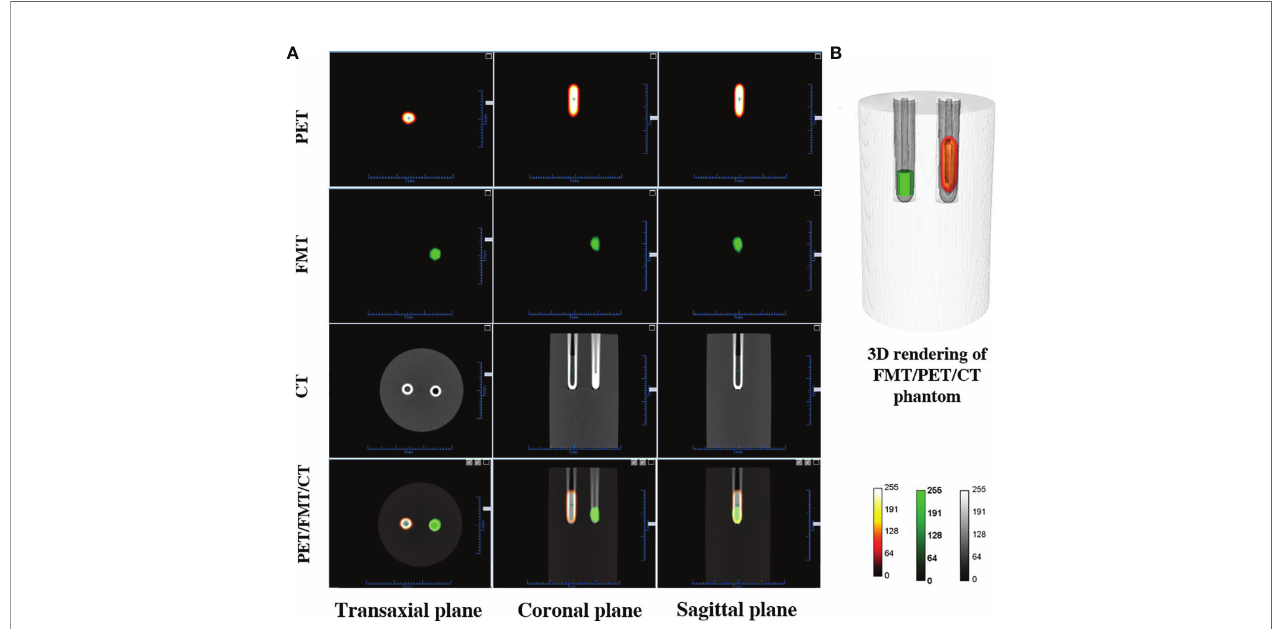
FIGURE 3 | Results for the multi-modality imaging. (A) PET, FMT, CT, and tri-modality fusion images. (B) Three-dimensional rendering of fusion images demonstrating co-registration color maps are used for the representation of the three different data sets in Figure 3A . The integrated tri-modality three- dimensional images are shown in Figure 3B . The ICG solution within the left capillary tube is displayed in green. The 18 F-FDG within the right capillary tube is shown by a hot spot representation. Taken together, our results indicate that our with a misalignment of less than 1 mm).